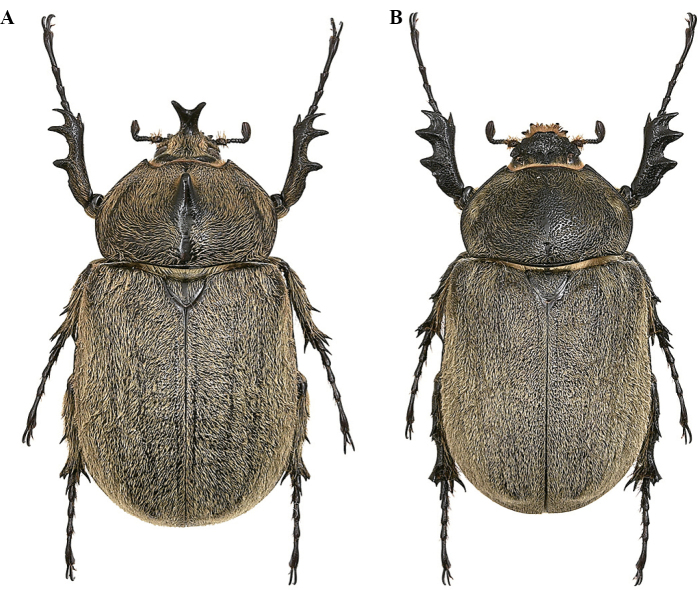
AM.
joergenseni
peynai ♂ BM.
joergenseni
peynai ♀.